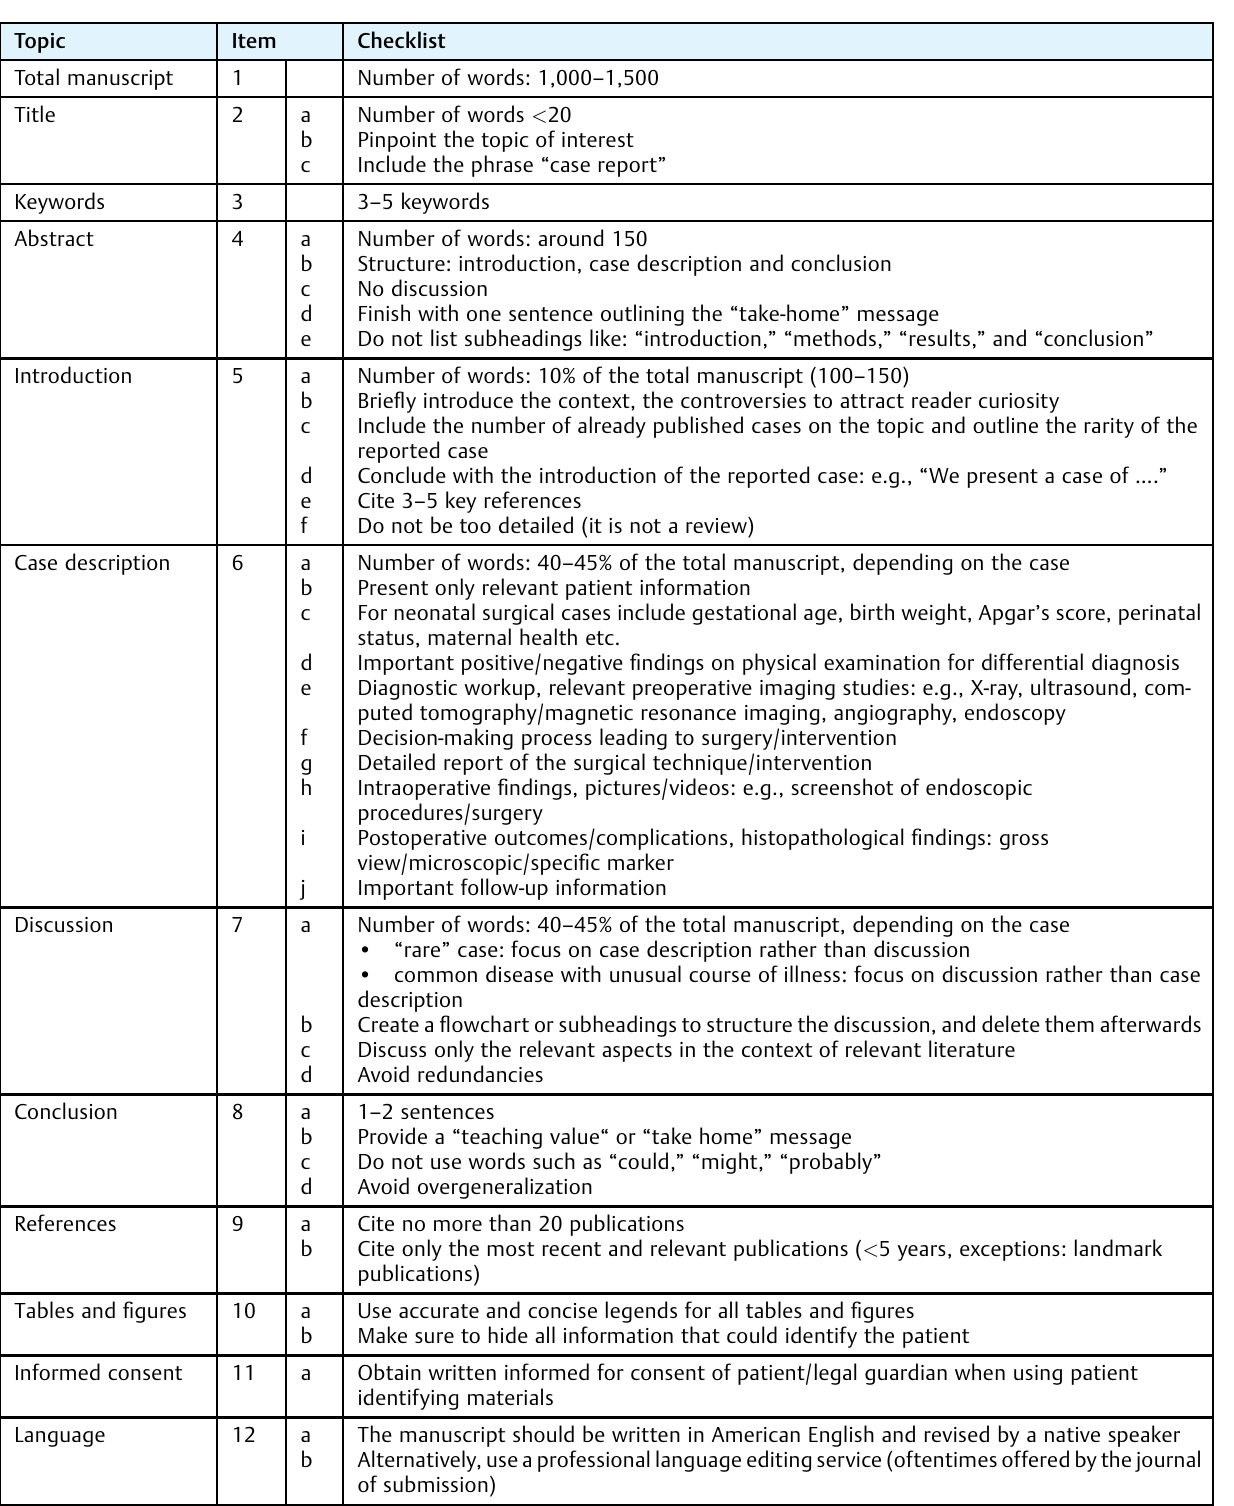
Table 1 Checklist for a case report in pediatric